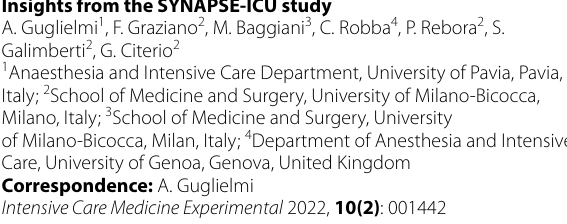
Figure 1 Diagram of enrolled patients; Abbreviations: TIL intensity Levels; ICU